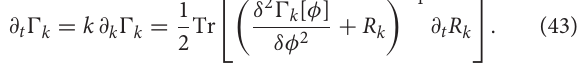
TABLE 1 | Relevant and leading irrelevant critical exponent as well as the anomalous dimension for the Ising model obtained with the FRG in a derivative expansion to leading order (local potential approximation, LPA, to order 2 n in the field) and next-to-order (LPA’) with field-independent anomalous dimension.